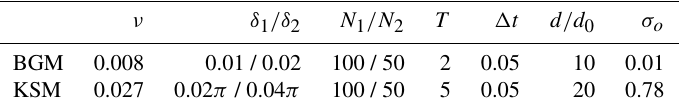
Table 1. Experimental setup parameters: ν is the viscosity, δ 1 and δ 2 the remeshing criteria, N 1 and N 2 are the number of nodes in the HR and LR fixed reference mesh, T is the duration of the experiments, (cid:49)t is the analysis interval, and d EUL and d LAG Eulerian observations and the initial number of Lagrangian observations.